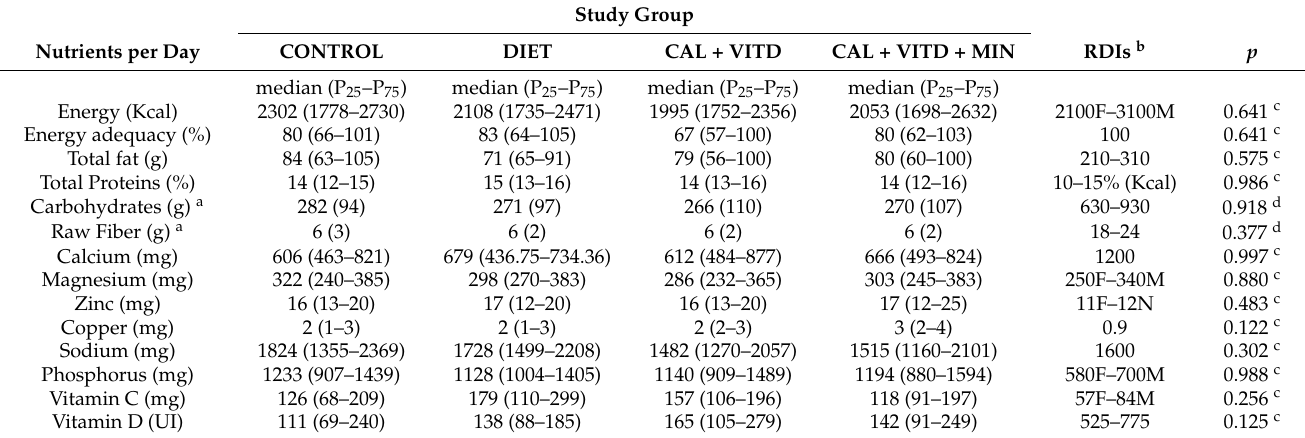
Table 2. Nutrients intake in donors according to the group of study.